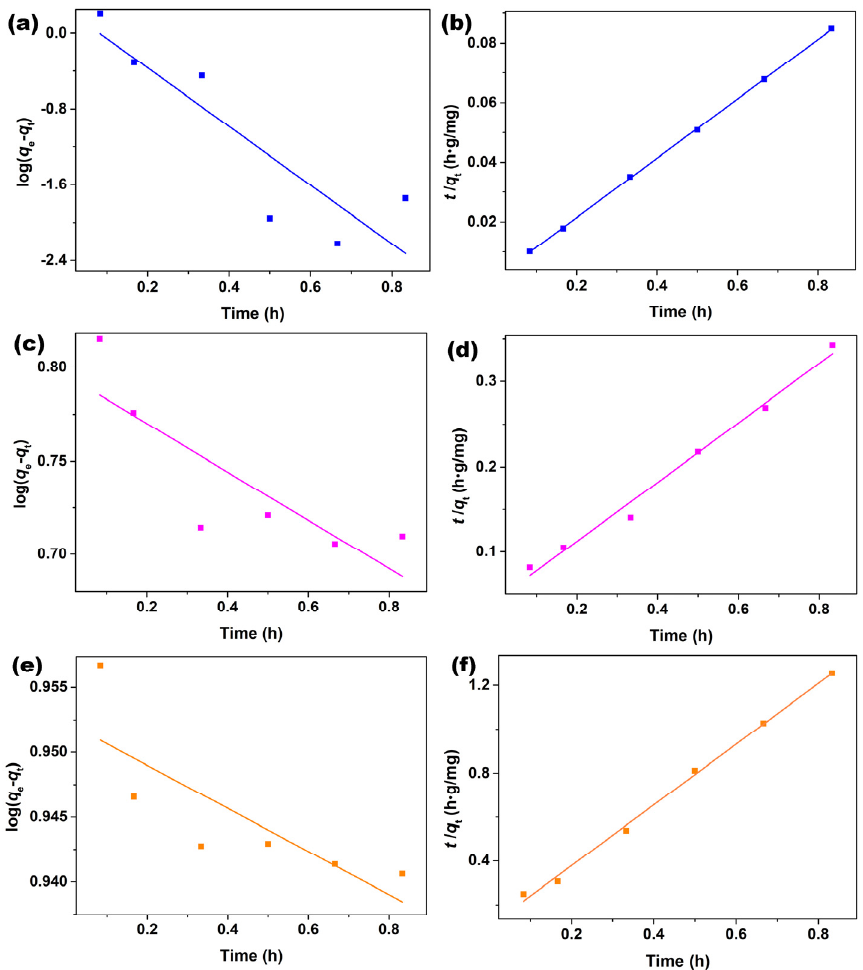
Figure 5. Fittings by a pseudo–first–order model for the adsorption of ( a ) XO, ( c ) BO2, and ( e ) AO7 dyes, pseudo–second–order model for the adsorption of ( b ) XO, ( d ) BO2, and ( f ) AO7 dyes onto Fe 3 O 4 nanoparticles. ([Fe 3 O 4 ] = 1.0 g/L; [dye] = 10 mg/L; Room temperature; without pH preadjust- ment). Table 4. Kinetic parameters for the adsorption of XO, BO2, and AO7 dyes onto Fe 3 O 4 nanoparticles at room temperature.